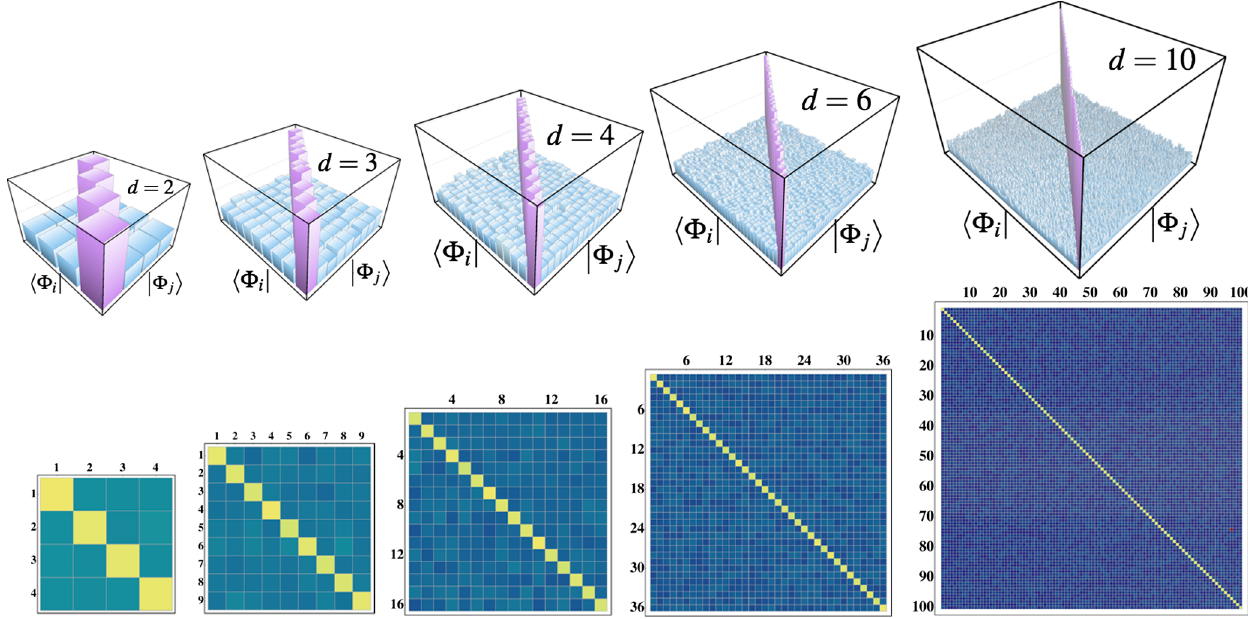
FIG. 3. Experimentally measured characterization of the generation and detection of SIC POVMs elements for different photonic qudit subspaces. Each block corresponds to P ij ¼ jh Φ i j Φ j ij 2 , where j Φ i i correspond to the i th SIC POVM element, i.e., Lower figures are the density plots of the upper histograms. Projecting SIC POVMs for each dimension d acquires d 2 set of